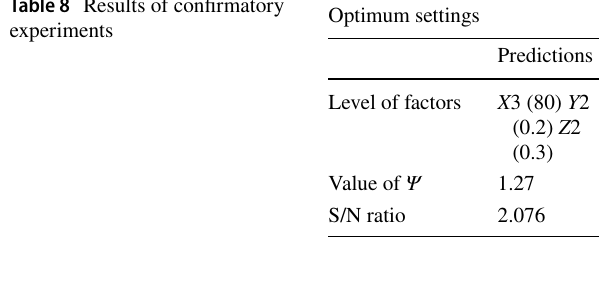
Table 10 ANOVA for the composite primary component (CPC)